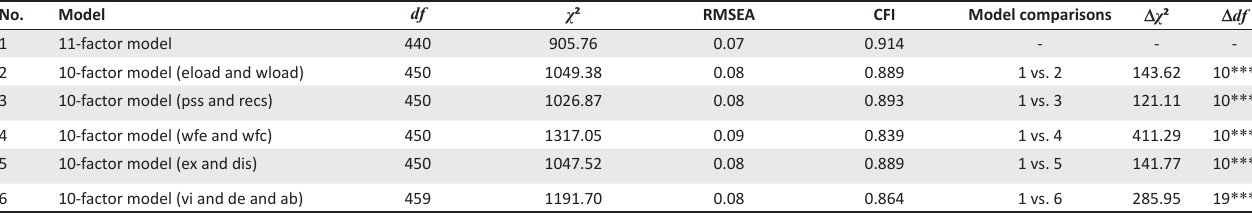
TABLE 1: Fit indices for measurement models ( N =